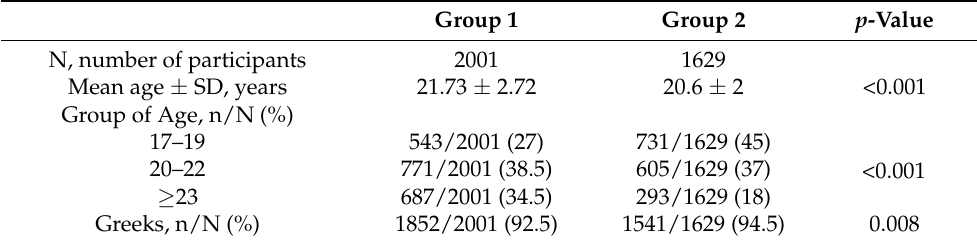
Table 1. Baseline characteristics of group 1 and group 2 participants.